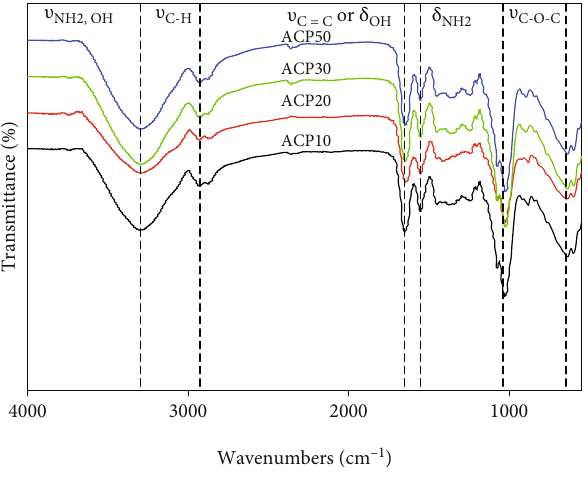
Figure 2: IR spectra of AG/CS/PP nanoparticles.